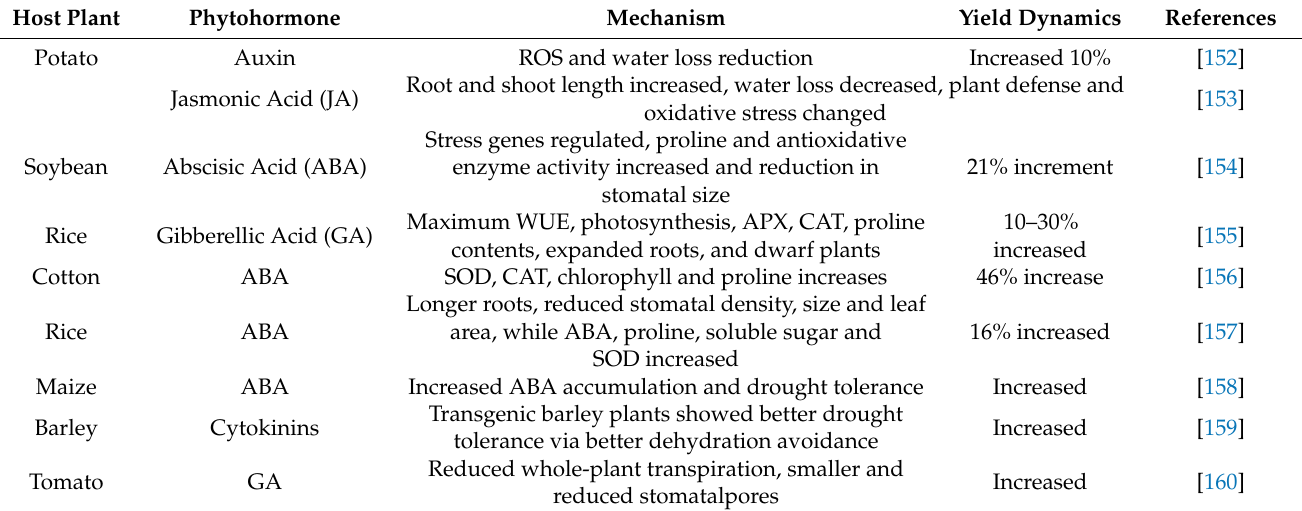
Table 3. Tolerance mechanisms to drought enhancement through phytohormones in different field crops.